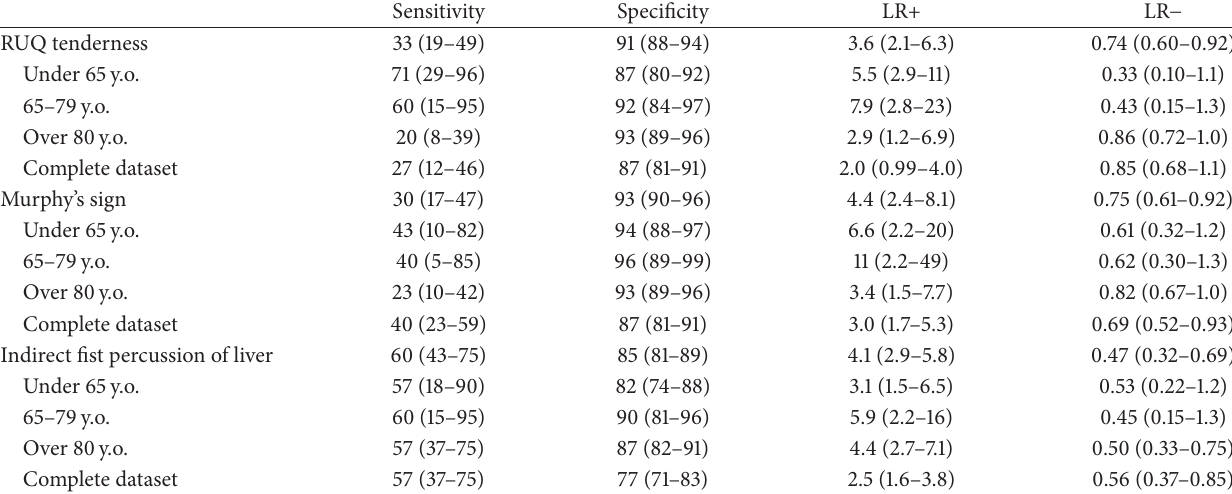
Table 2: Diagnostic accuracy for hepatobiliary